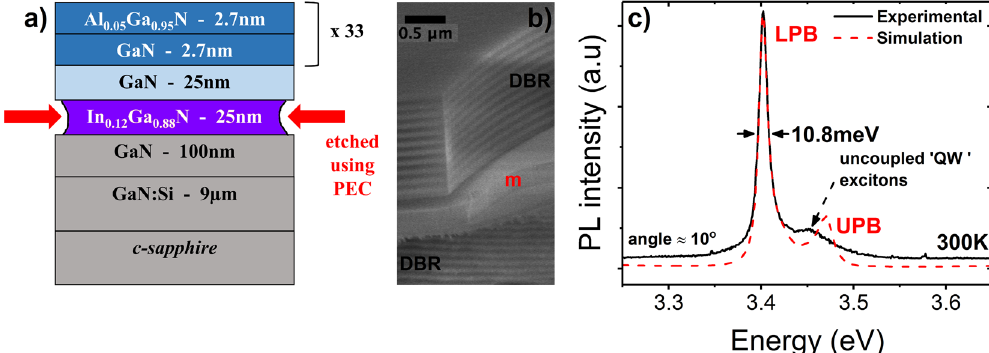
Figure 1. Fabrication of an all-dielectric microcavity. ( a ) Basic structure of the sample under study, highlighting the InGaN sacrificial layer to be removed by photo-electrochemical etching. ( b ) SEM image of a full microcavity, where we distinguish the 3 λ /2-thick membrane (“m”) sandwiched between two dielectric DBR mirrors. ( c ) PL spectrum at an incident angle of 10° (black line), from a full microcavity sample, along with its simulation (dashed red line). The LPB and the uncoupled ‘QW’ exciton lines are visible in the spectrum. The expected UPB location is